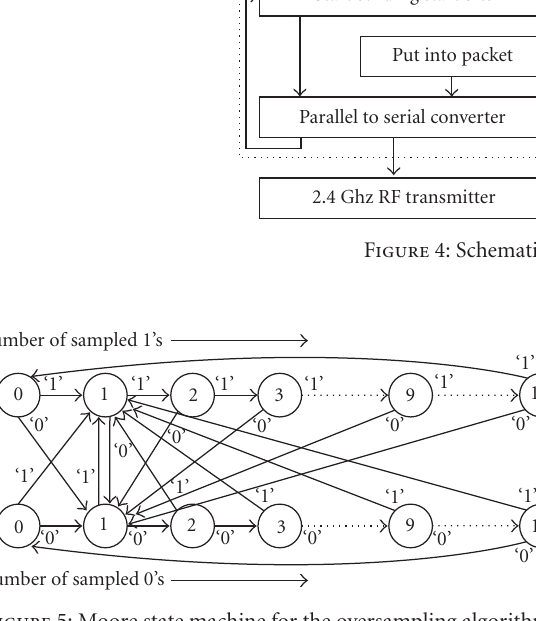
Figure 5: Moore state machine for the oversampling algorithm.